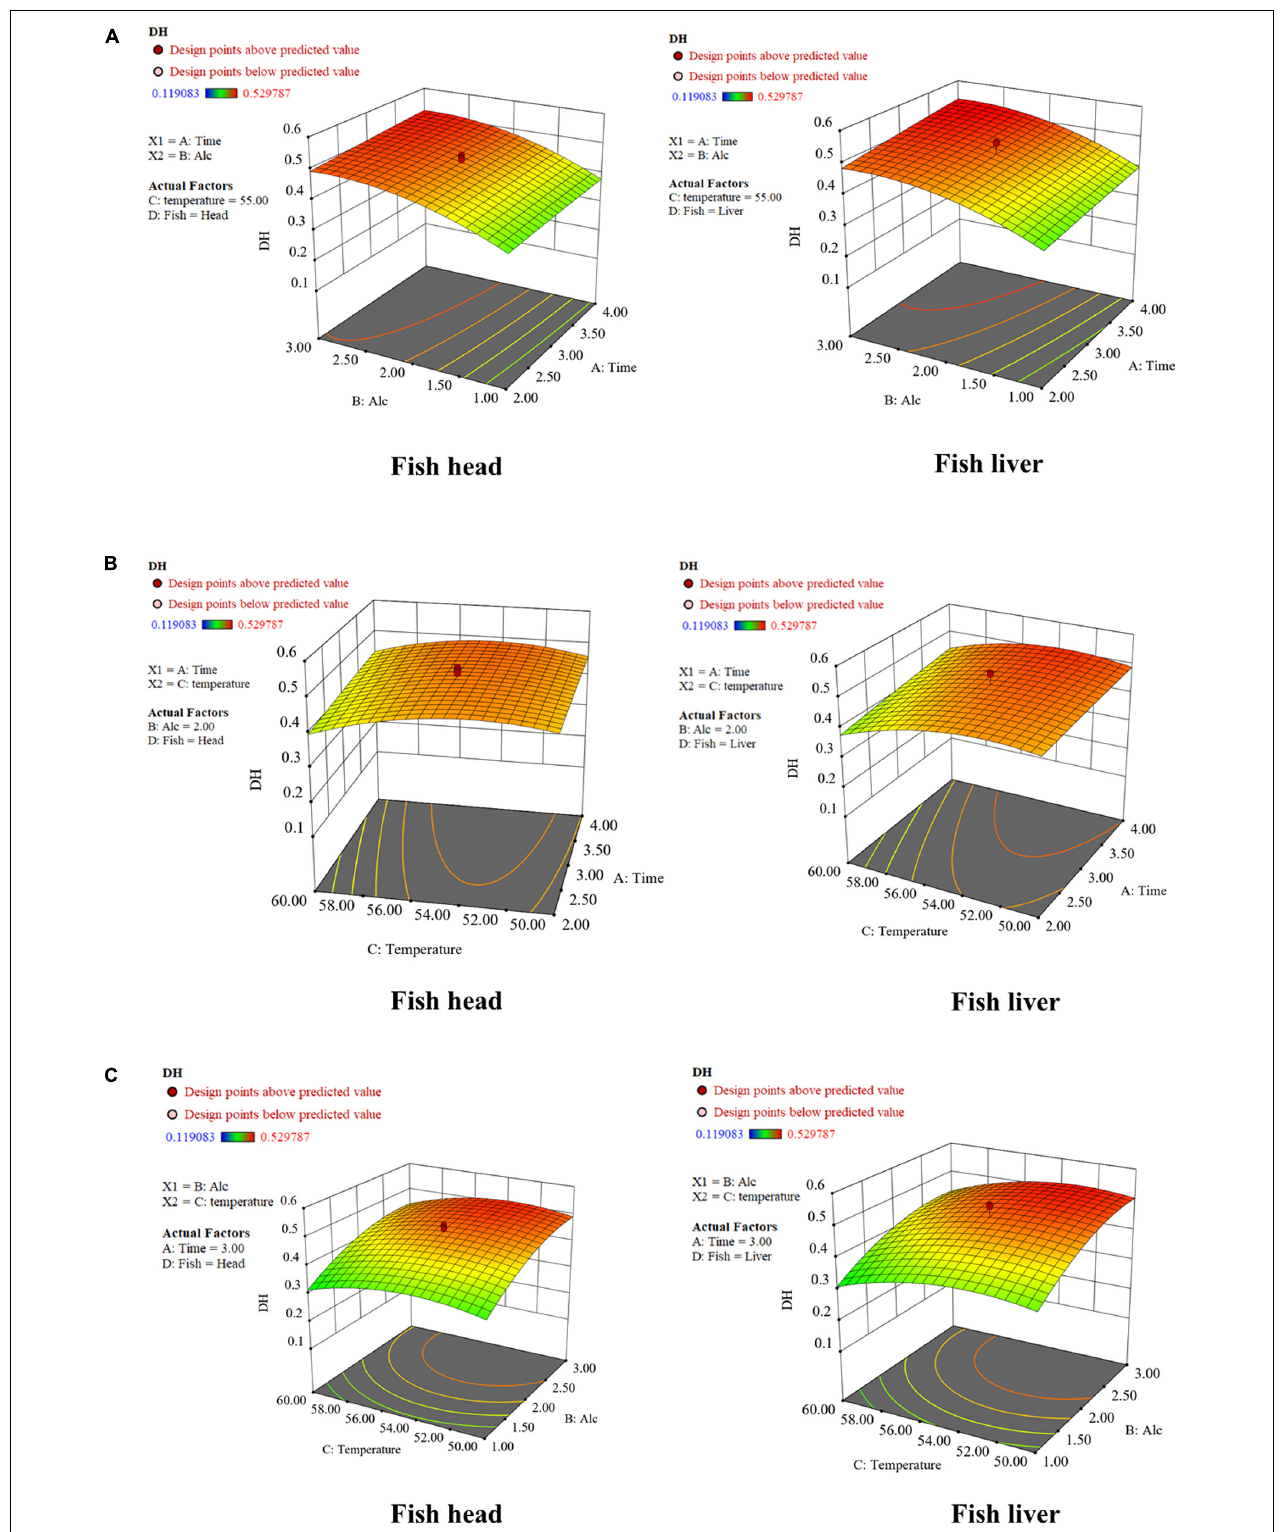
FIGURE 2 | Response surface graphs for degree of hydrolysis (DH) as a function of (A) time and enzyme dose; (B) temperature and time; (C) temperature and enzyme dose. Fifty grams of fish waste sample [fish head (FH) or fish liver (FL)] were hydrolyzed separately by Alcalase R (cid:13) 2.4 L following the experimental conditions listed in Table 1 . The hydrolysis conditions were optimized by employing the RSM with Central Composite Design.